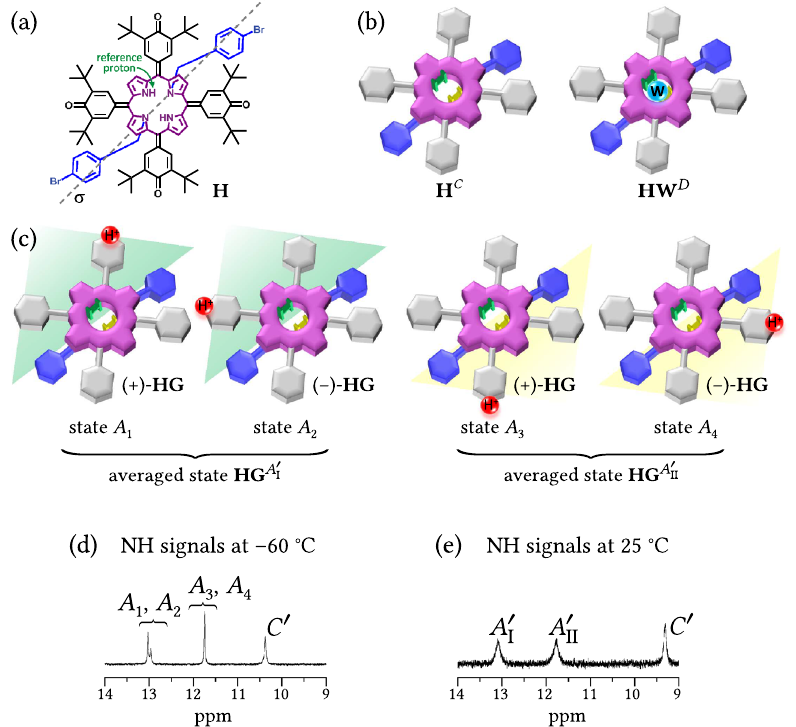
Figure 6. Spin states of central NH protons of di-bromobenzylated oxoporphyrinogen host molecule ( H ). ( a ) Structure of H . Bromobenzyl groups are situated behind the molecule. The spin states are described with respect to reference proton denoted by green arrow. ( b ) Schematic representation of free host H C and host– water complex HW D inducing the spin states denoted in superscript. ( c ) Protonated host–guest complex in two distinct tautomeric forms ( )- HG and (−)- HG differing in the site of protonation. NH spins of ( )- HG + + tautomer can be present in two spin states HG A 1 or HG A 3 (similarly NH spins of (−)- HG can be in states HG A 2 or HG A 4 ) depending on the carbonyl protonation proximity to the green-labeled reference proton. Different sites of protonation within the green and yellow zones form the averaged states A ′ I and A ′ II , respectively. Guest anion stabilizing the host–guest complex 14 is not shown since it does not affect the structure of spin states (see details in the text). The superscripts (e.g., H C , HG A 1 ) denote the spin state with respect to the green-labeled 4 M 1 , CDCl 10 reference NH proton. ( d , e ) 1 H NMR spectra of NH resonances of host H ( 8.4 3 ) with − − × 60 ◦ C and ( e ) 25 ◦ C. In ( d ), the presence of four states A 1 , ..., A 4 of protonated H 0.59 equiv. of guest G at ( d ) − can be recognized (intensity ratio of the peaks at 13.03 and 12.96 ppm is 74:26). In ( e ), only two averaged